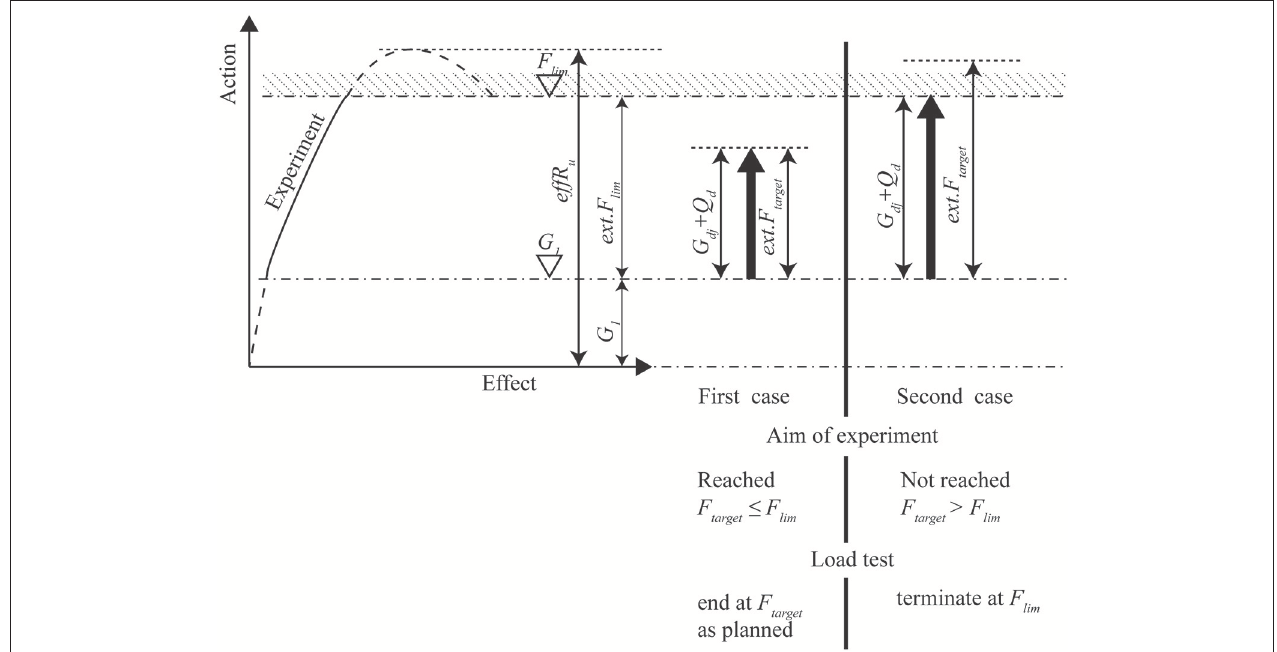
FIGURE 1 | Philosophy of load testing as given in German guideline (Deutscher Ausschuss für Stahlbeton, 2000). Figure reprinted from Lantsoght et al. (2017g) with